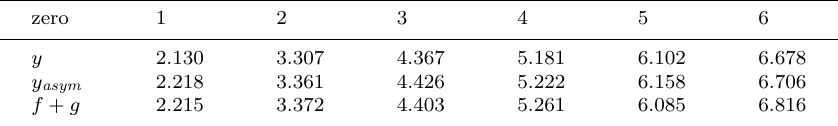
Table 2. Zeros of fractional oscillations as in (3.14) with y (0) = 0, y (cid:48) (0) = 1, α = 0 . 75, λ = − 2 and q ( x ) = x . Zeros in rows from the top: exact solution, approximate solution (3.16) and approximate formulas (4.4) and (4.5).